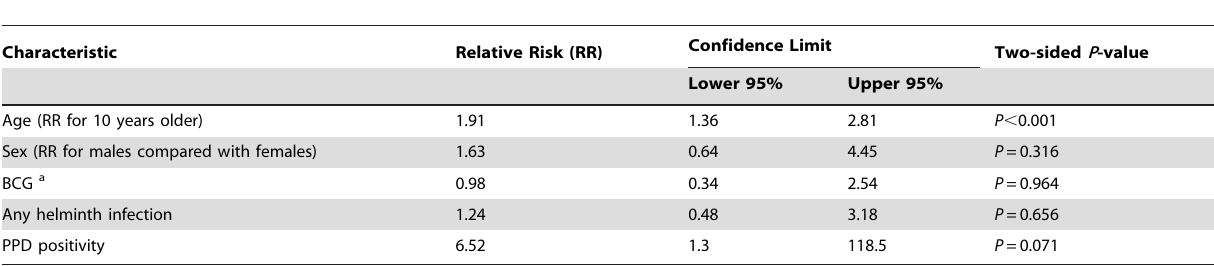
Table 4. Results Using the Generalized Linear Model for Prospective